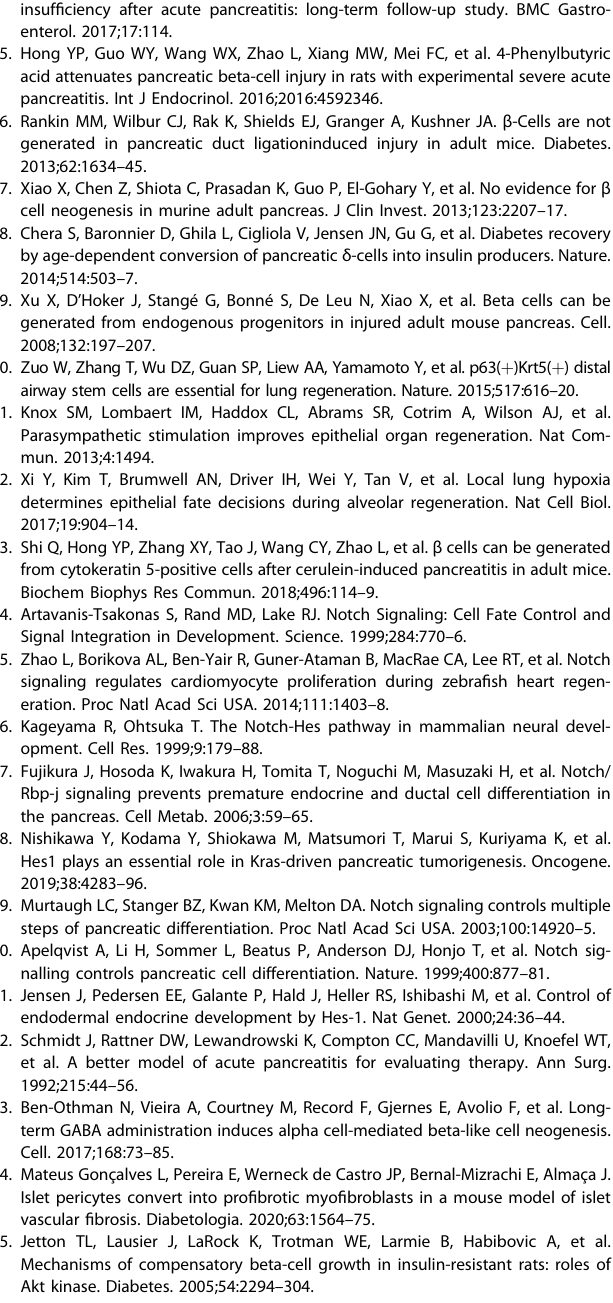
Fig. 7 Increased Krt5 + cells differentiation toward beta cells following Notch inhibition in vitro. a Schematic depicting the protocol of primary cell isolation. b Images of primary cells isolated from pancreases of control and AP mice. c Identi fi cation of Krt5 + cells with immunostaining of Krt5 (green) and DAPI (blue) in isolated primary cells from control and AP mice. d Representative western blots of Rbpj and Hes1 in isolated primary cells from control and AP mice. e , f Quanti fi cation of western blots for Rbpj ( e ) and Hes1 ( f ) in cells isolated from AP mice vs control mice. g Western blot analyses of Rbpj and Hes1 expression in primary cells from AP mice treated with various concentrations of DAPT for 72 h. h , i Quanti fi cation of western blots for Rbpj ( h ) and Hes1 ( i ) in cells isolated from AP mice supplemented with various concentrations of DAPT for 72 h. j Representative images of cells with and without DAPT treatment immunostained with Krt5 (green), insulin (red) and DAPI (blue) showing the increased proportion of double-positive Krt5 + and insulin + cells, suggesting more Krt5 + cells differentiated into beta cells following Notch inhibition. k Schematic representation showing Krt5 + cells differentiated toward beta cells following downregulation of Notch activity. l Images of cells isolated from AP mice supplemented with DAPT showing the increased proportion of insulin + cells after 72 h culture compared with cells without DAPT treatment. m Quanti fi cation of insulin + cells (shown as %) after 72 h culture with and without DAPT treatment. n Measurement of insulin content in cells isolated from AP mice treated with various concentrations of DAPT